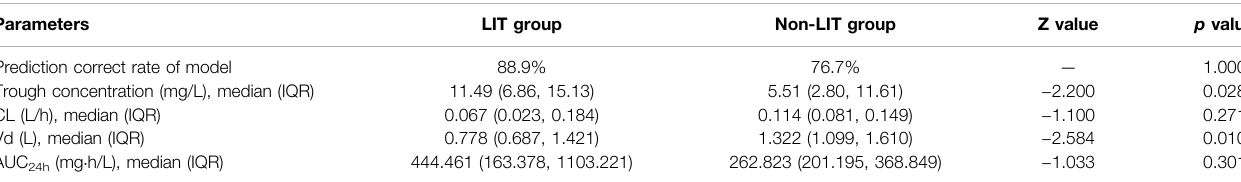
TABLE 3 | Dosage, trough concentration, and pharmacokinetic parameters of LZD in neonatal patients. Parameters